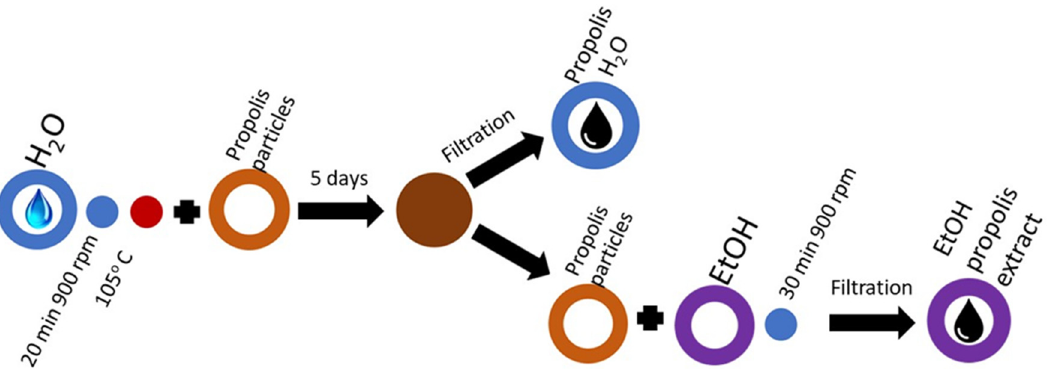
Figure 4. Mixing sequence required for laboratory-made propolis water (PW/BRA Lab) and ethyl alcohol propolis extract (PEx/BRA Lab) preparation.